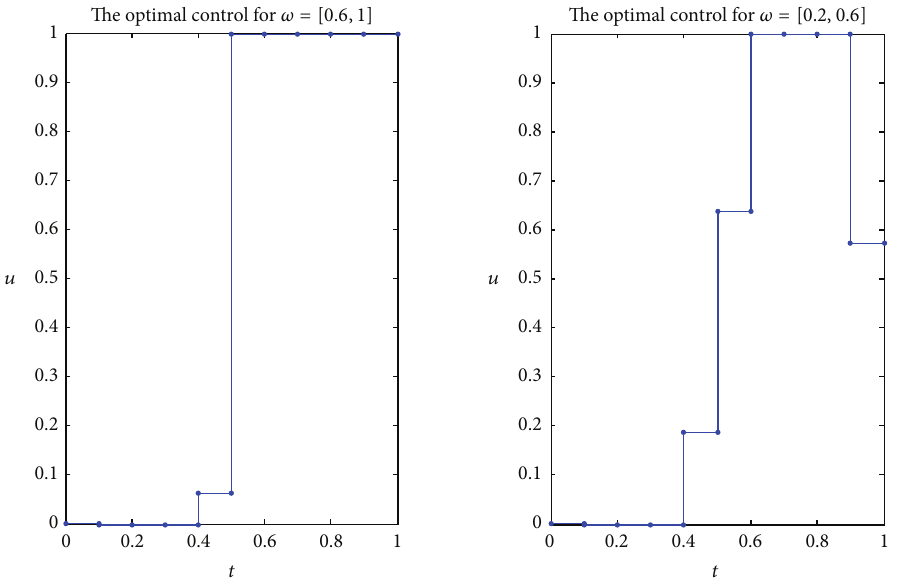
Figure 2: The optimal controls for ( OCP ) 1 and ( OCP ) 2 .